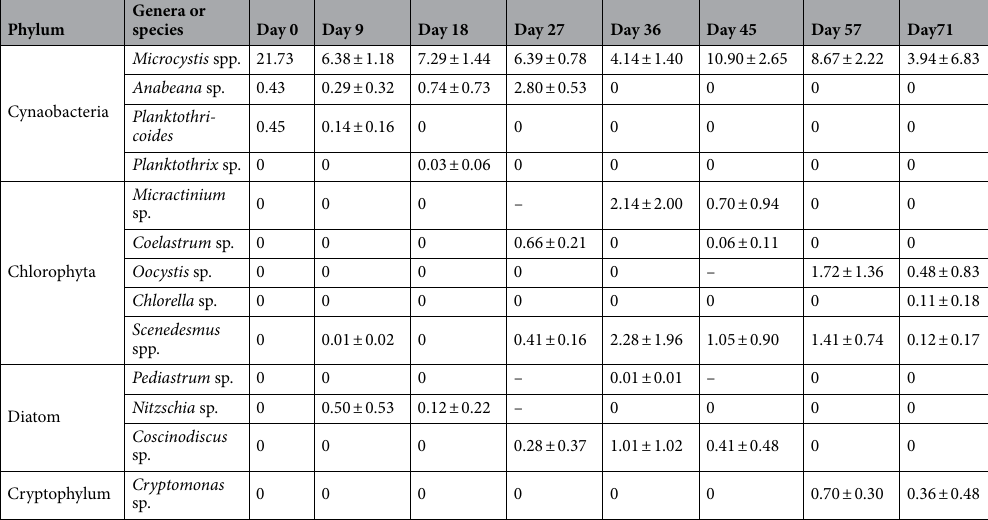
Table 2. Algal changes in the five dominant genera in the control (wet weight, mg L −1 ).